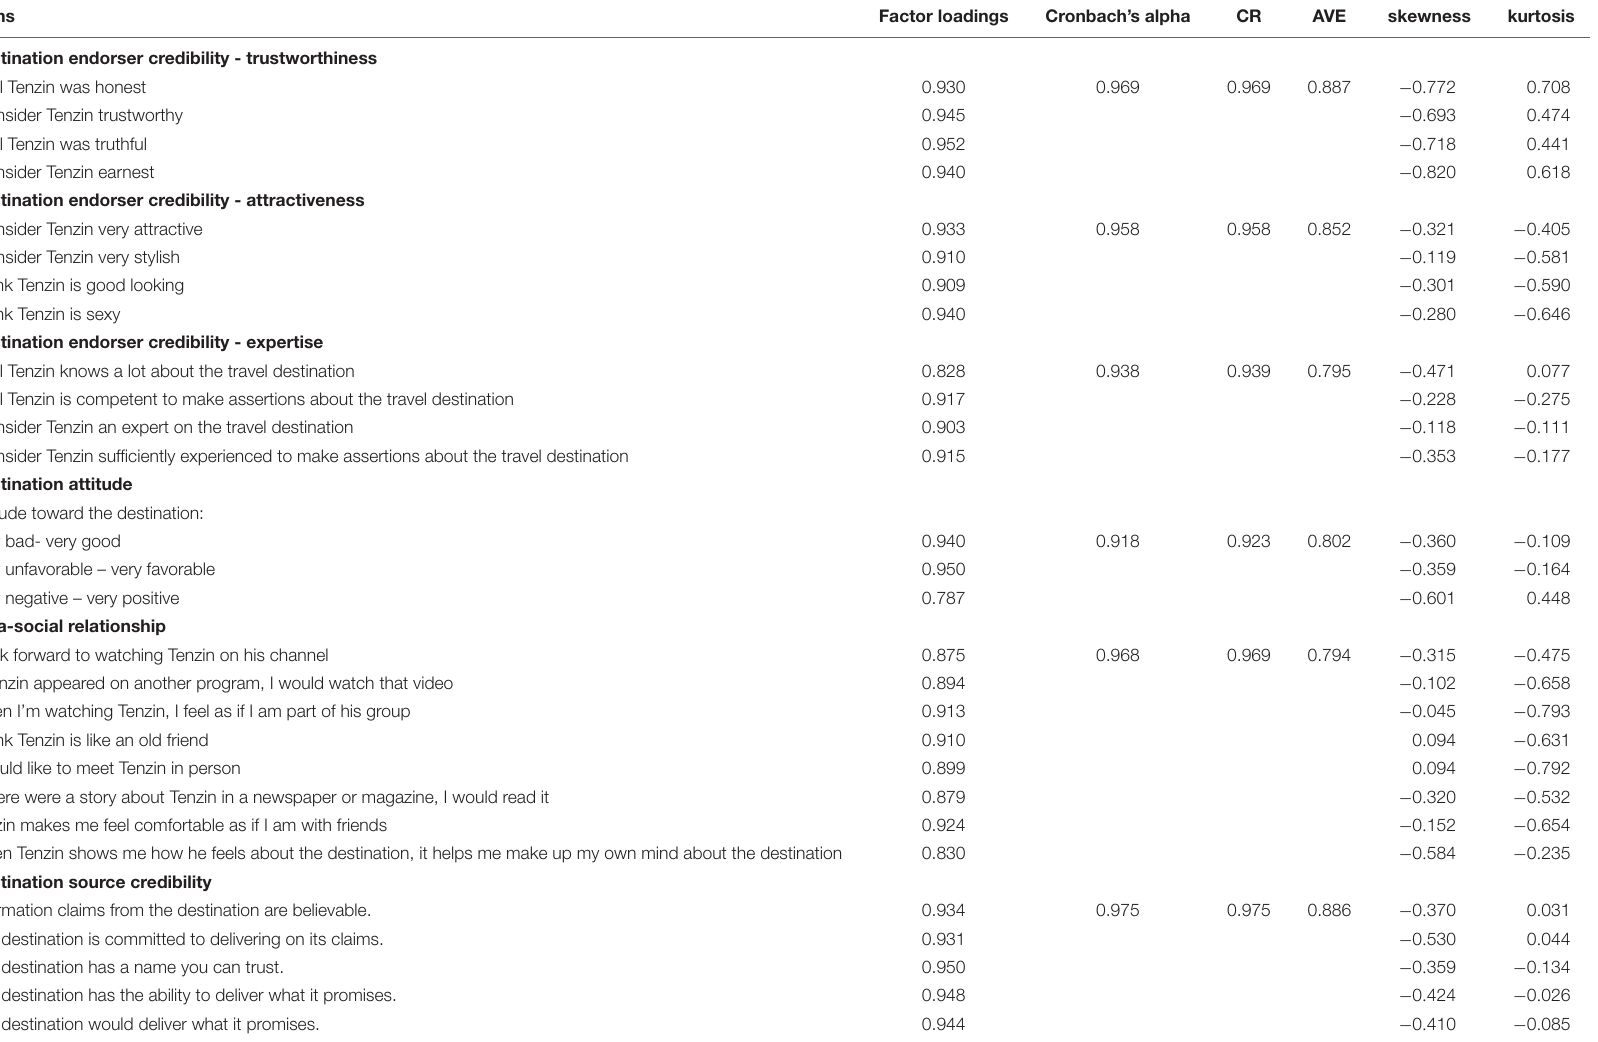
TABLE 2 | Reliability, convergent validity, and normality assessment.